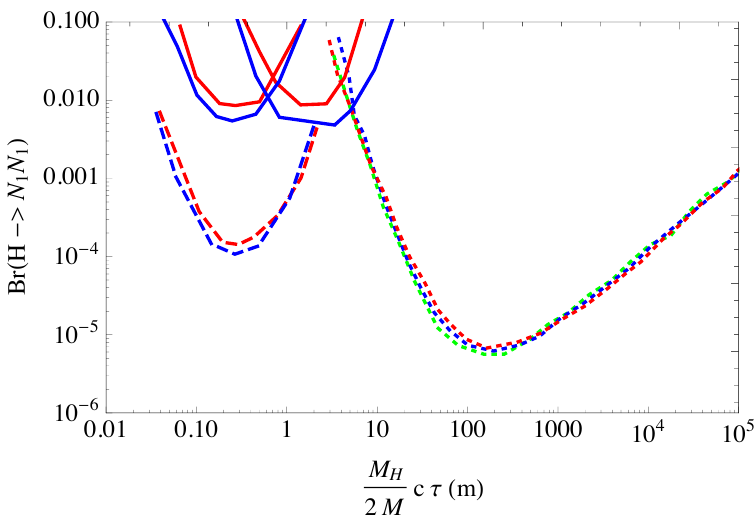
Figure 9 . Expected limits at LHC (13 TeV, 300 fb (cid:0) 1 ) on the BR ( H N 1 N 1 ) for scenario A ! as a function of M H c(cid:28) in meters. The solid lines correspond to the IT and MC analyses with 2 M M 1 = 20GeV (blue) and M 1 = 35GeV (red) for NH and CP phases (cid:14) = 0 ; (cid:30) 1 = (cid:25)= 2. The dashed lines are for IH and the same CP phases for IT/MC . The dotted lines correspond to the estimated reach of Mathusla in the HL-LHC (14TeV, 3000 fb (cid:0) 1 ) [58] for masses 5 ; 20 ; 40GeV, assuming that all the decays of N 1 are